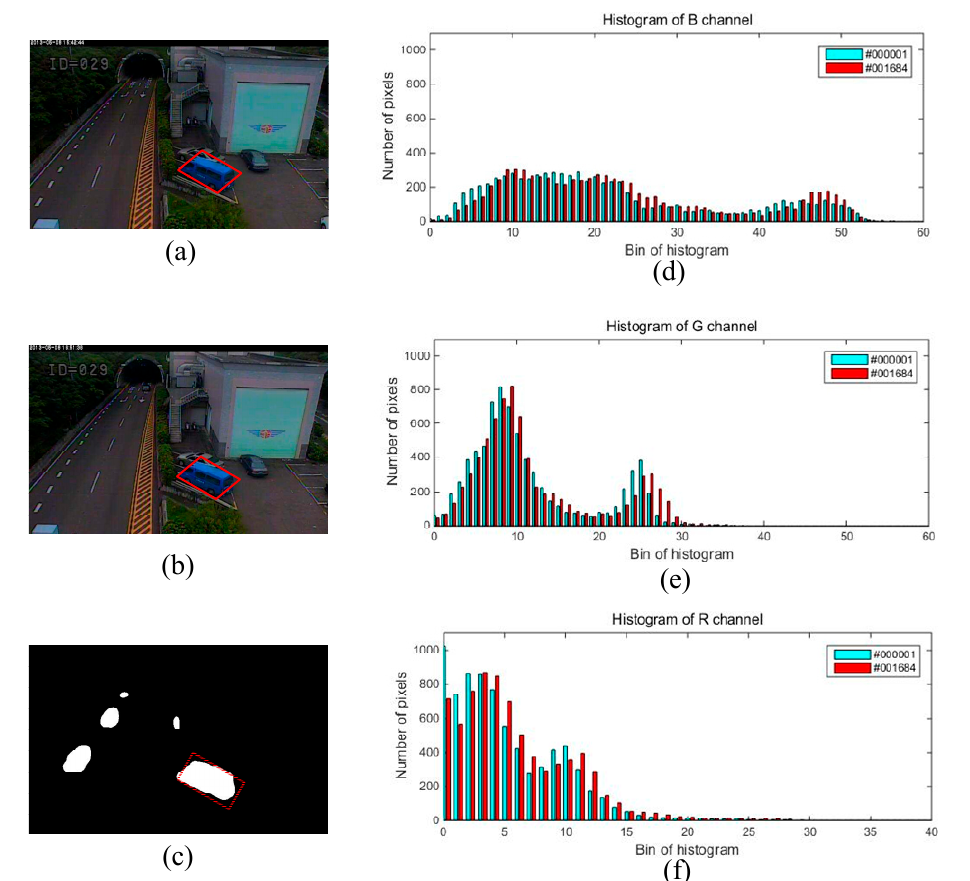
Figure 4. Histogram comparison of ghost region between #000001 and #001684. The region marked using red (cid:3) is the approximate location of the ghosts: ( a ) #000001; ( b ) #001684; ( c ) detection result of #001689; ( d ) histogram of B channel; ( e ) histogram of G channel; ( f ) histogram of R